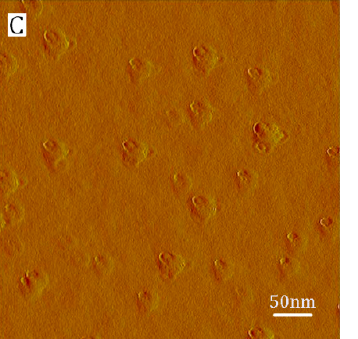
Figure 3. Absorption spectrum of PIC-@-Au 20 NPs throughout time upon addition of 0.1 g/mL KCN ( A ). Hydrodynamic diameter distributions ( B ). AFM image ( C ), and TEM image ( D ) of PICsomes 20 .